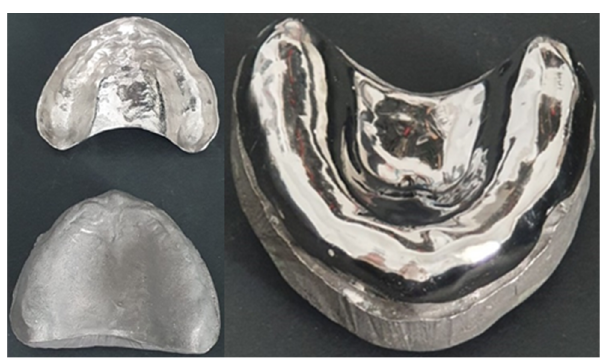
Figure 1. Prefabricated model. 2. The multiplication of the prefabricated mold was carried out with a Dosper Evo (Dreve Dentamid GmbH, Unna, Germany) duplicating machine using the Z-Dupe 28 shore A silicone (base + catalyst) (Henry Schein, Melville, New York, USA) (Figure 2).